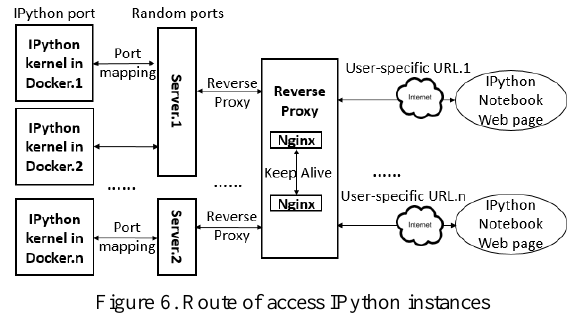
Figure 6. Route of access IPython